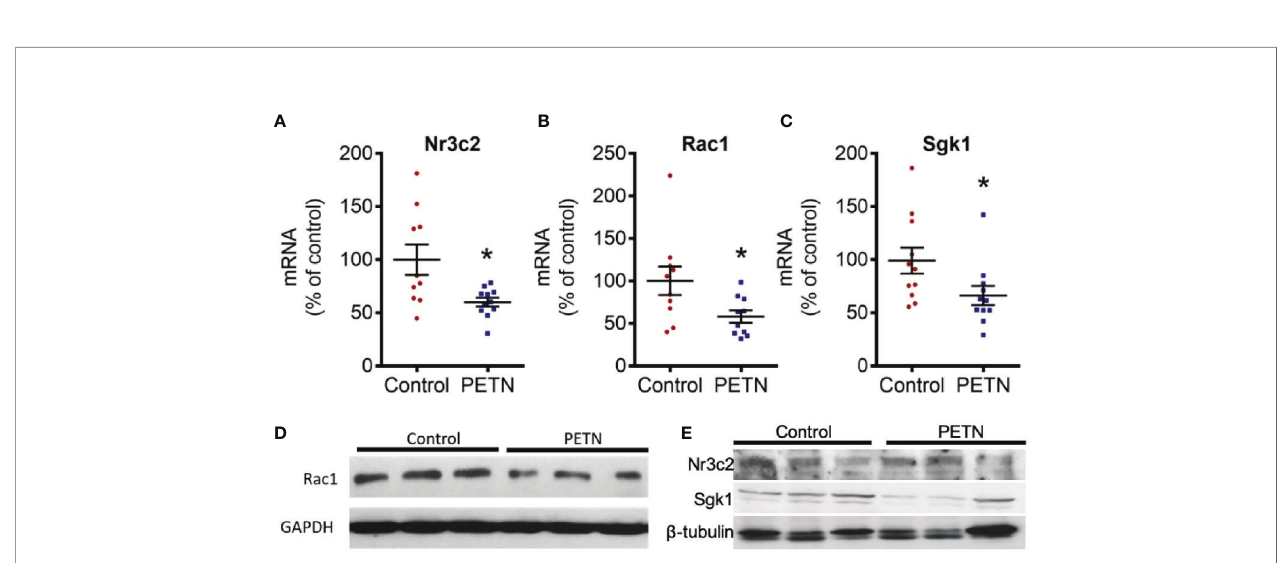
FIGURE 6 | Maternal pentaerythritol tetranitrate (PETN) treatment prevents activation of mineralocorticoid receptor in the kidney female offspring. Parental spontaneously hypertensive rats (SHR) were treated with or without PETN (50mg/kg/day) during pregnancy and lactation periods. The gene expression of mineralocorticoid receptor (MR or Nr3c2) (A) , Ras-related C3 botulinum toxin substrate 1 (Rac1) (B) and serum and glucocorticoid-regulated kinase 1 (Sgk1) (C) in the kidney of 16-weeks old offspring were studied with quantitative real-time PCR. RNA polymerase II was used as reference gene for qPCR. Protein expressions Rac1 (D) Nr3c2 and Sgk1 (E) were analyzed by Western blotting using kidney of 16-week-old offspring. GAPDH or b -tubulin was used as internal control for the protein loading in Western blotting. Column represents mean ± SEM, n=10 – 11. Student ’ s t test was used for comparison of PETN group with control group. * P < 0.05, vs. control